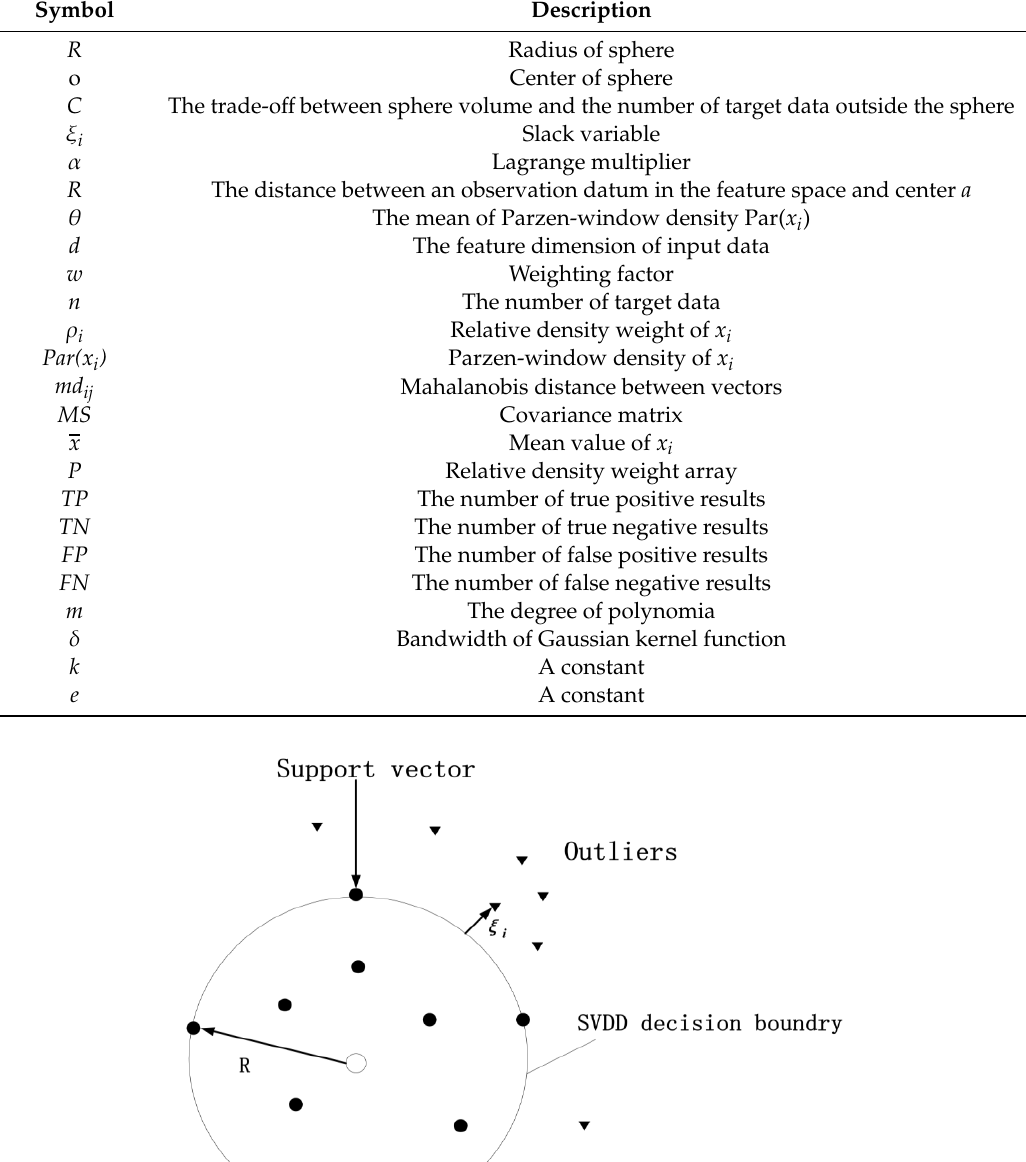
Table 1. Key notations.